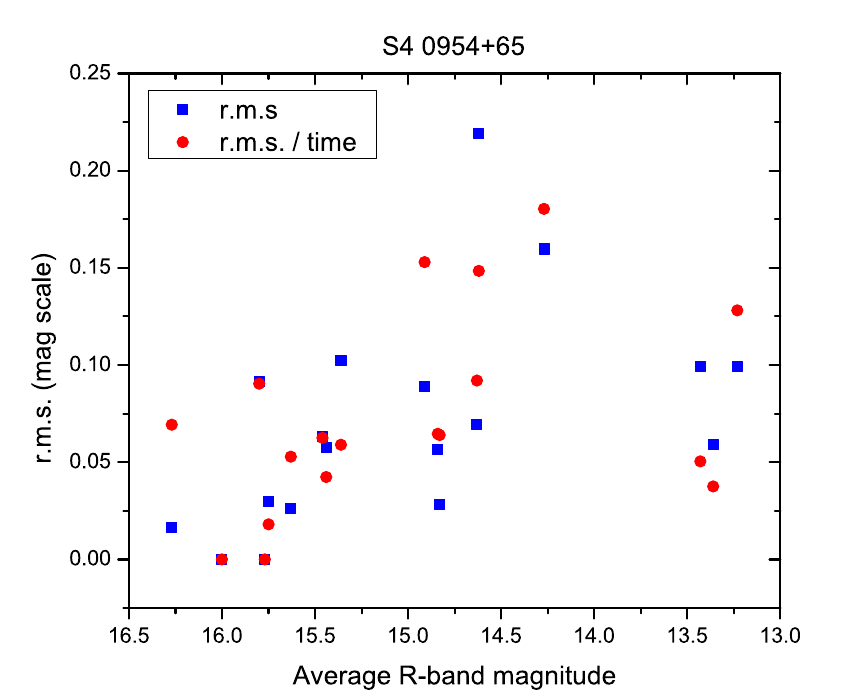
Figure 5. Examples of rapid intra-night variability.